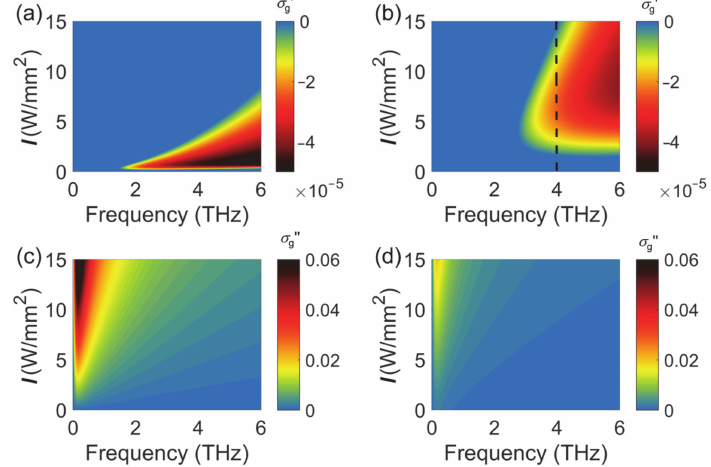
Figure 1. Conductivity of graphene at THz frequencies under optical pump. ( a ) Real part at 77 K. ( b ) Real part at 300 K. ( c ) Imaginary part at 77 K. ( d ) Imaginary part at 300 K. Unit: